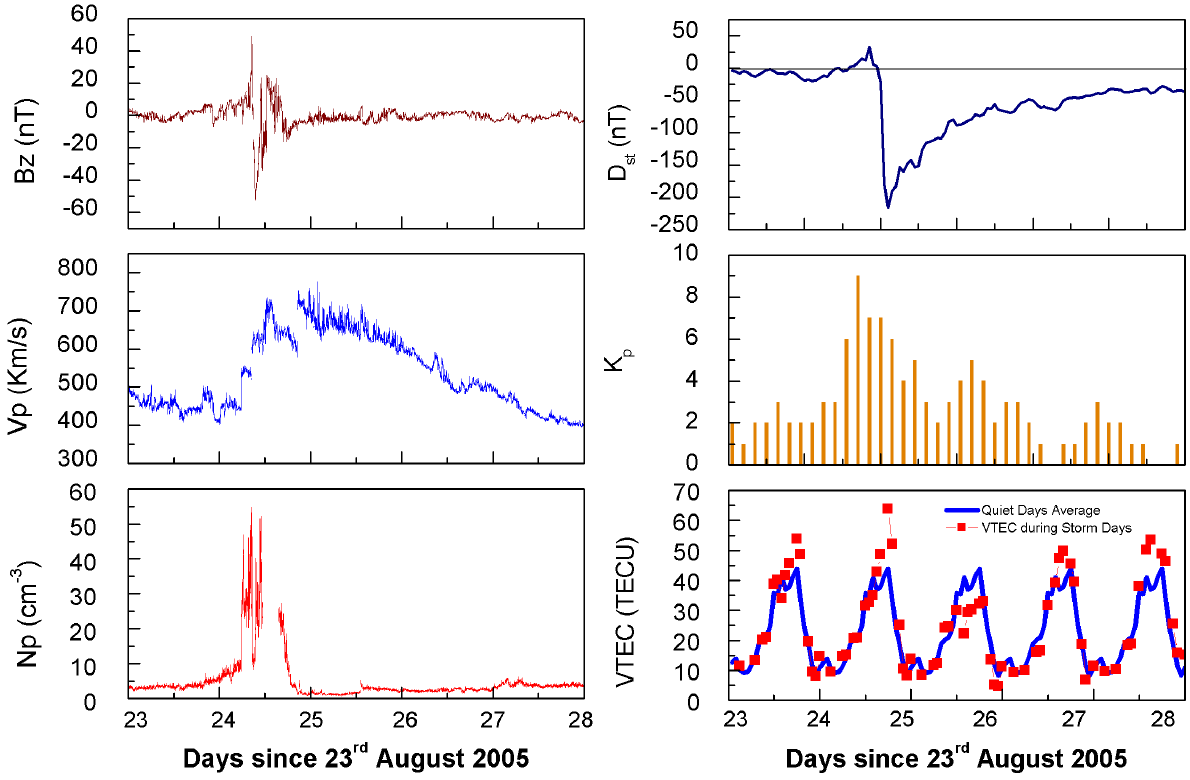
Fig. 6. (a) The variations of interplanetary magnetic field B z , solar wind velocity V p , and proton density N p during geomagnetic storm event of 23–27 August 2005. (b) The variations of D st , K p and TEC (red dashed line) during 23–27 August 2005. The quiet days’ mean TEC of the month is shown by the solid blue line in the bottom panel (day hours are in